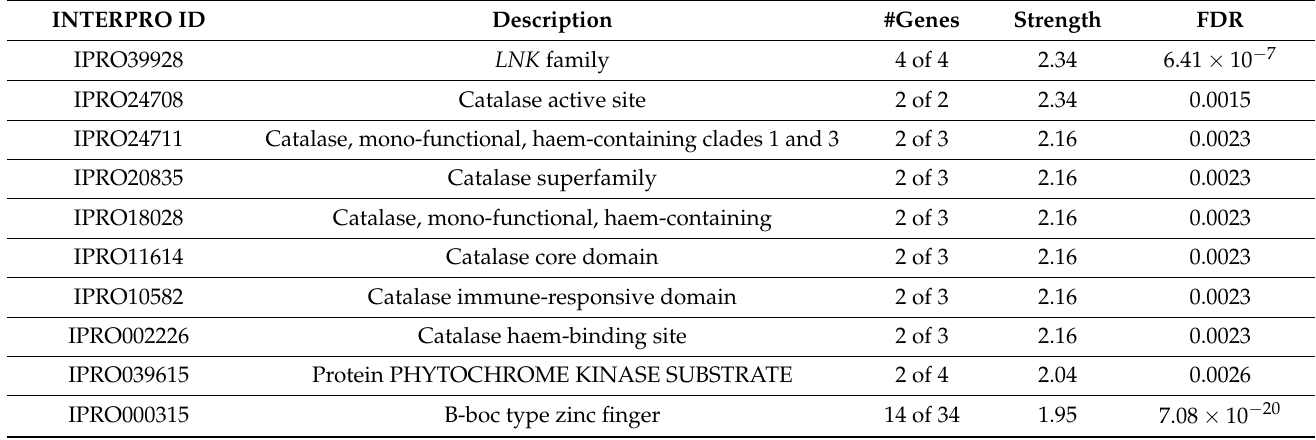
Table 3. INTERPRO enriched terms in WT network specific genes.